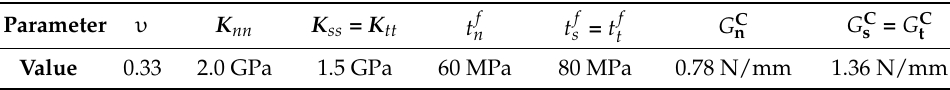
Table 5. Material properties of the interface